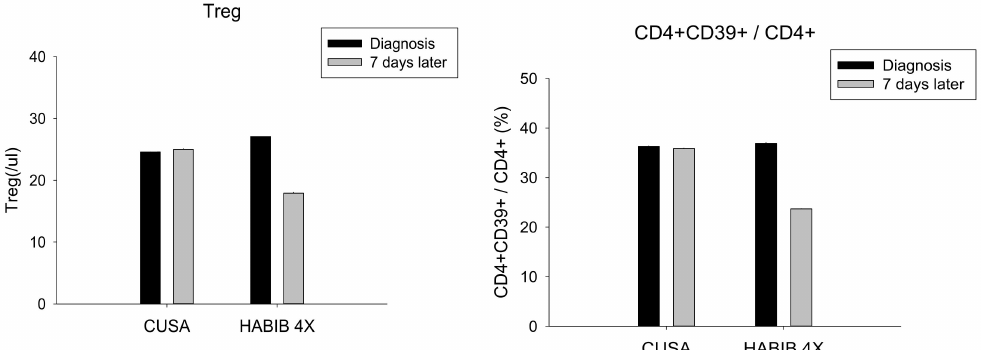
Figure 2. Treg cells and the CD4 + CD39 + /CD4 + cells changes in both study groups. A significant decrease was observed in both cell types in the Habib TM 4X group.